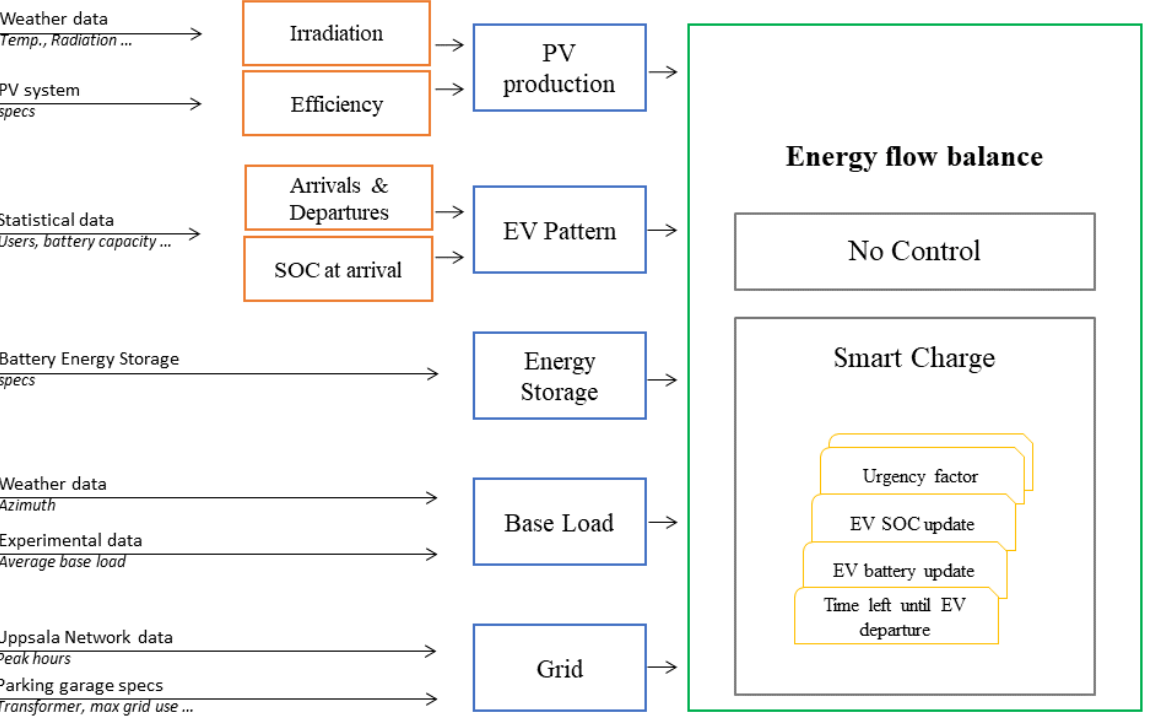
Figure 1. Diagram showing the model blocks. The inputs to the model on the left side are fed to the model blocks.